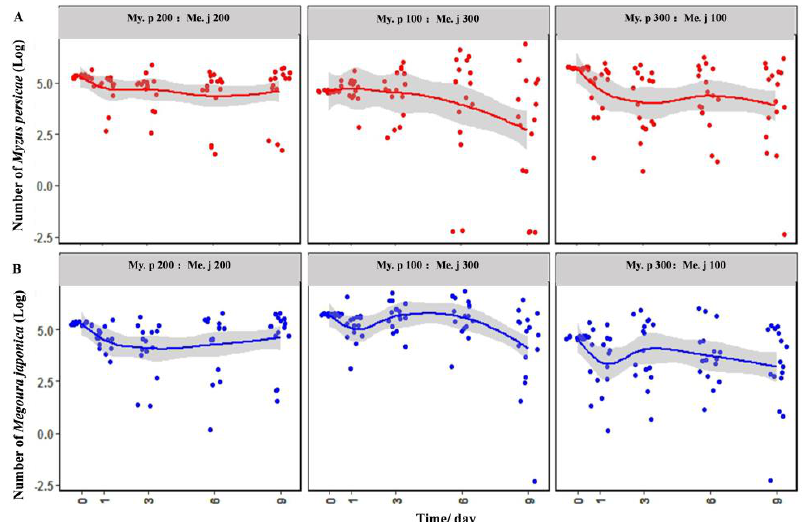
Figure 4. The population dynamics of Myzus persicae ( A ) and Megoura japonica ( B ) at different initial ratios. My. p represents My. persicae , and Me. j represents Me. japonica .